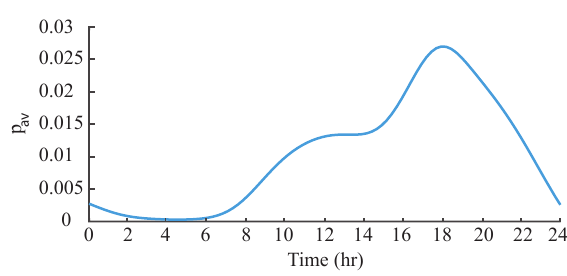
Figure 13. The probability of the EV arriving at home in one day.